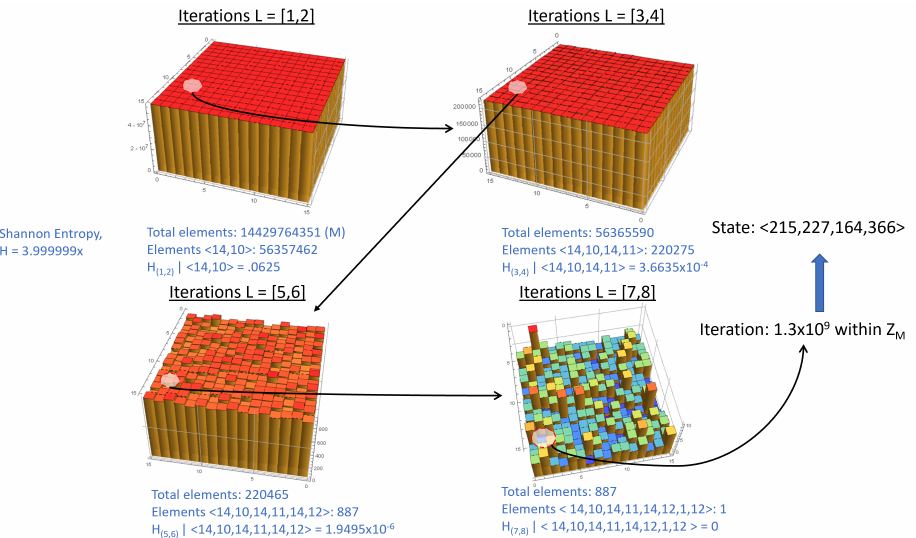
Figure 11. A visualization of the pruned search as it converges on a single